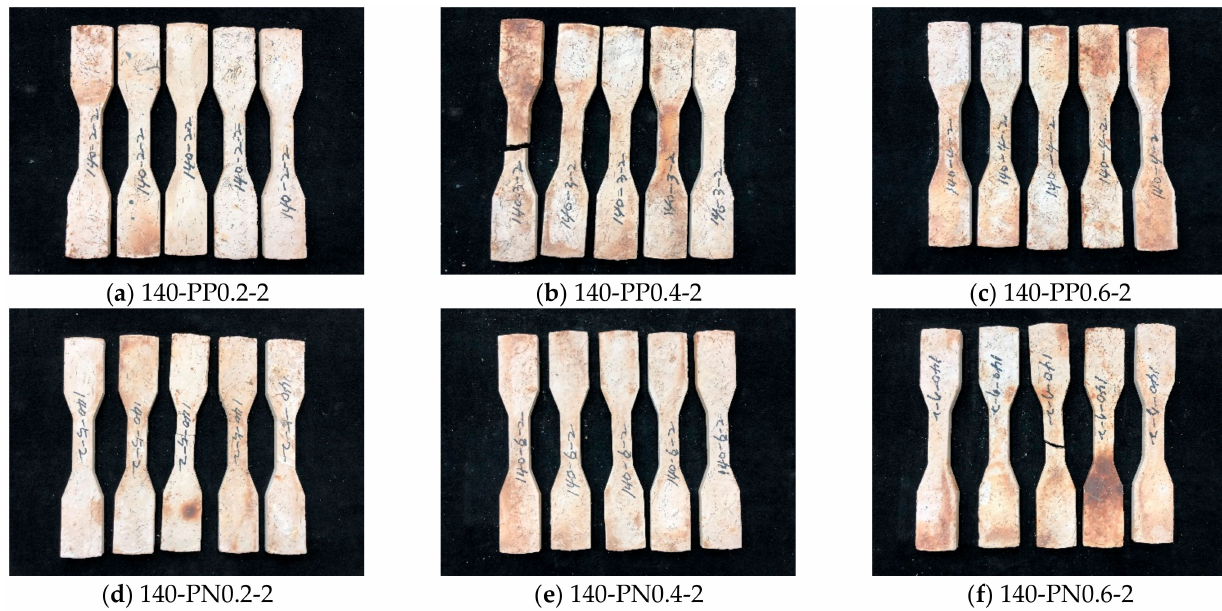
Figure A2. Appearance of the 140 MPa specimens after 2 h of fire